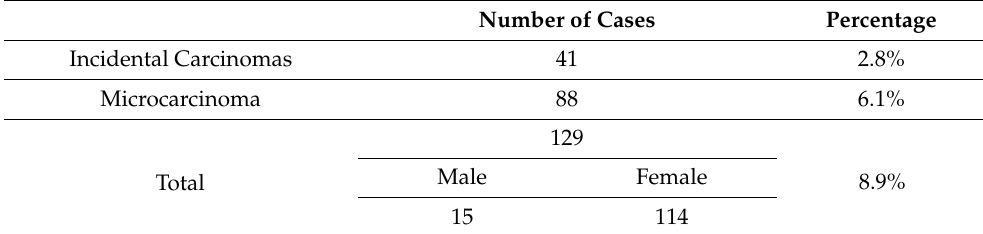
Table 1. Incidental cancer by histological type and gender distribution.